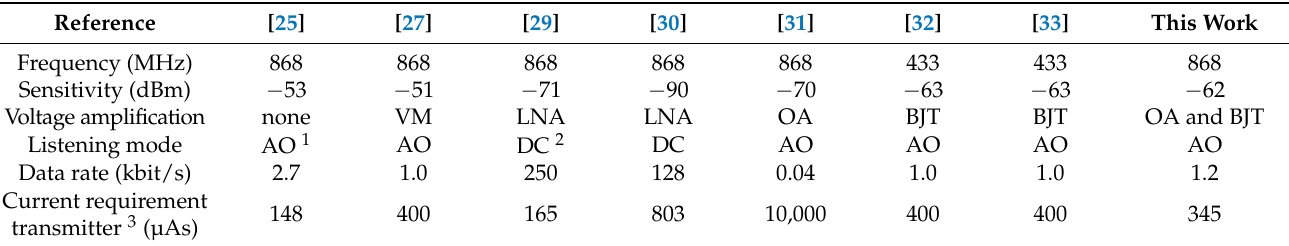
Table 1. Comparison of data rate and wake-up